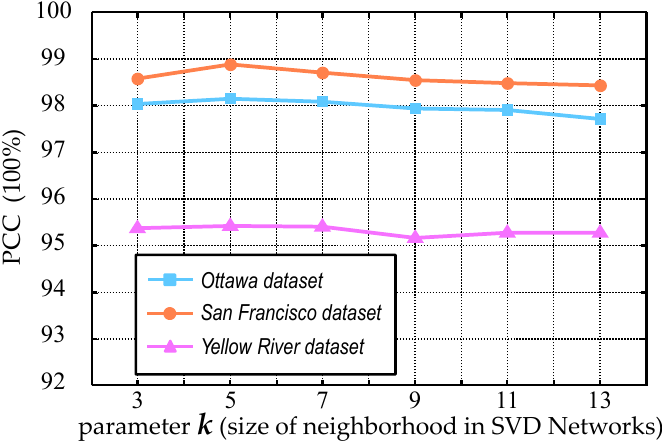
Figure 13. Relationship between PCC and the parameter (cid:1863) on three SAR datasets.